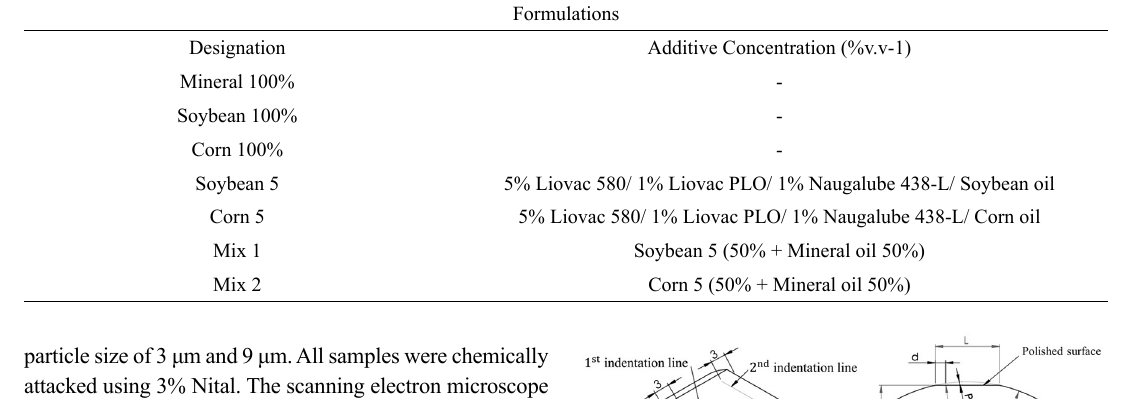
Table 2. Cutting fluid formulations.